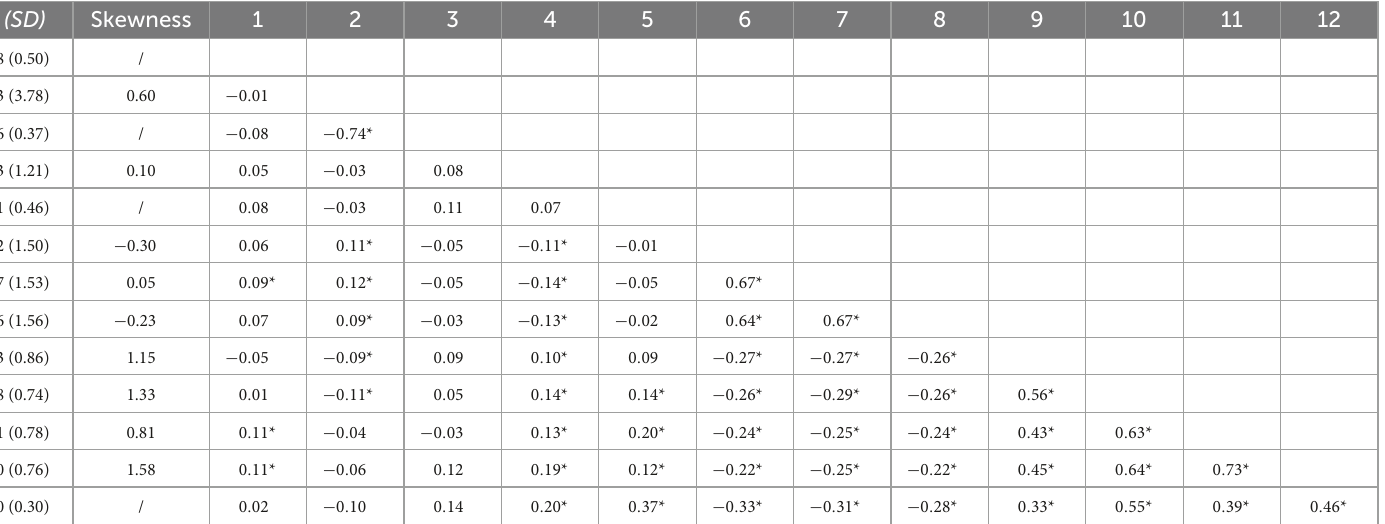
TABLE 1 Descriptive statistics and polychoric correlations of the study variables in the